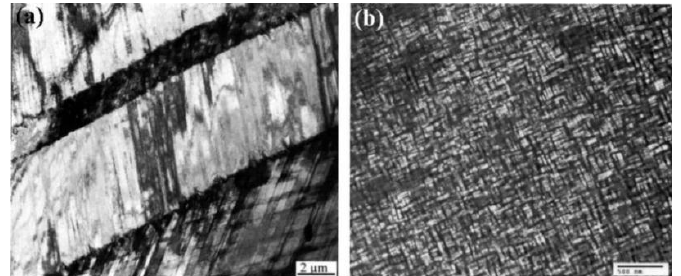
Figure 6. ( a ) TEM bright-field image exhibiting shear bands on {111} planes in the austenitic matrix, ( b ) TEM dark-field image showing the regular arrangement of κ -carbides. (Reprinted with permission from [3] , copyright Wiley, 2016).